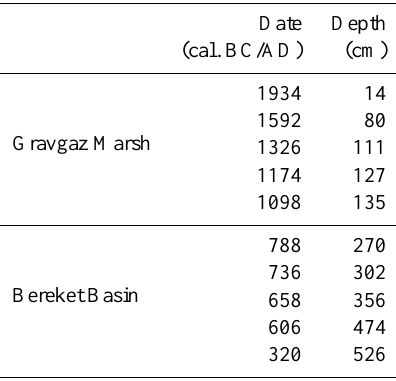
Table 6. List of dates (cal. BC/AD) per sediment core of fire events as determined by the CharAnalysis